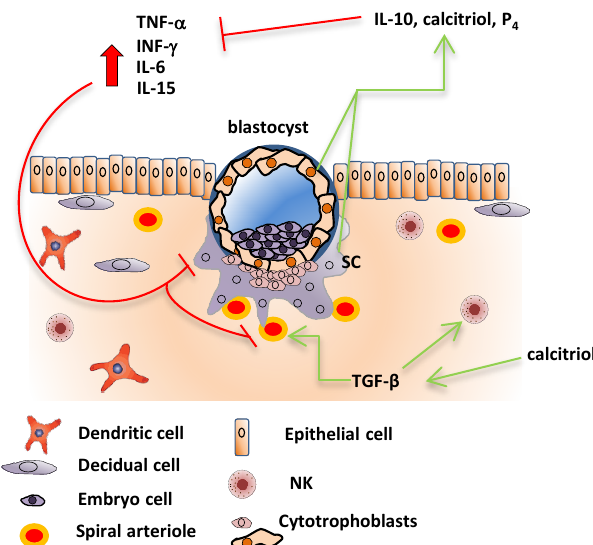
Figure 2. Cytokine profile during implantation. An early state of controlled inflammation at the feto-maternal interface is needed to promote adequate trophoblast invasion. TNF- α controls trophoblast growth and invasion of maternal spiral arteries, limiting excessive trophoblastic penetration. Another placental cytokine involved in this process is TGF- β , which interacts with its receptor endoglin in blood vessels and controls trophoblast invasion/penetration. TGF- β produced by macrophages interacts with NK cells, making them accept trophoblasts while avoiding them to kill fetal cells. In order to prevent excessive inflammation that could result in the rejection of the fetal allograft, calcitriol, IL-10, and progesterone (P ) produced by decidual cells, trophoblasts, and syncytiotrophoblasts act as anti-inflammatory factors modulating the immunological milieu. Calcitriol and IL-10 may also be produced by immune cells present in the feto-maternal interface. Calcitriol is also known to induce TGF- β .